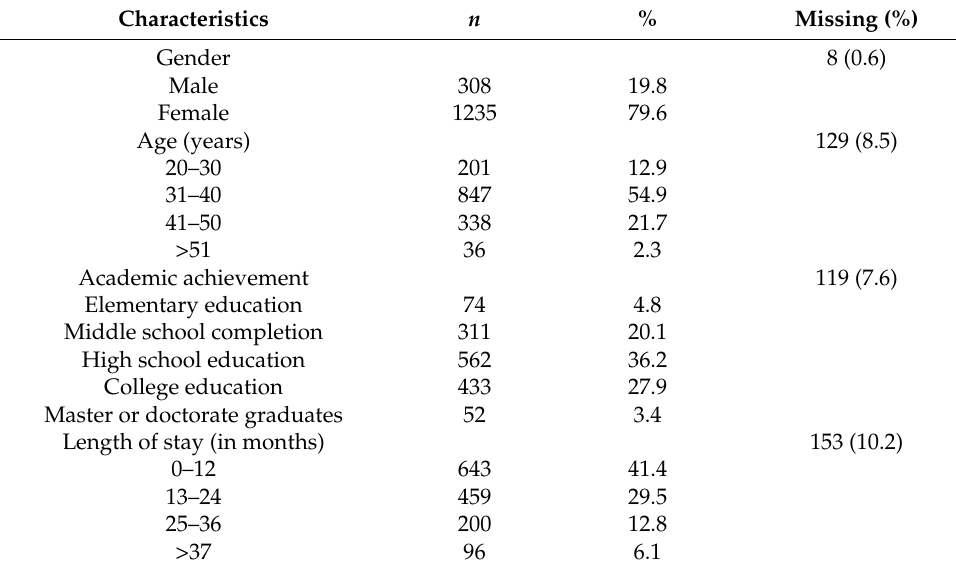
Table 1. Sociodemographic characteristics of the